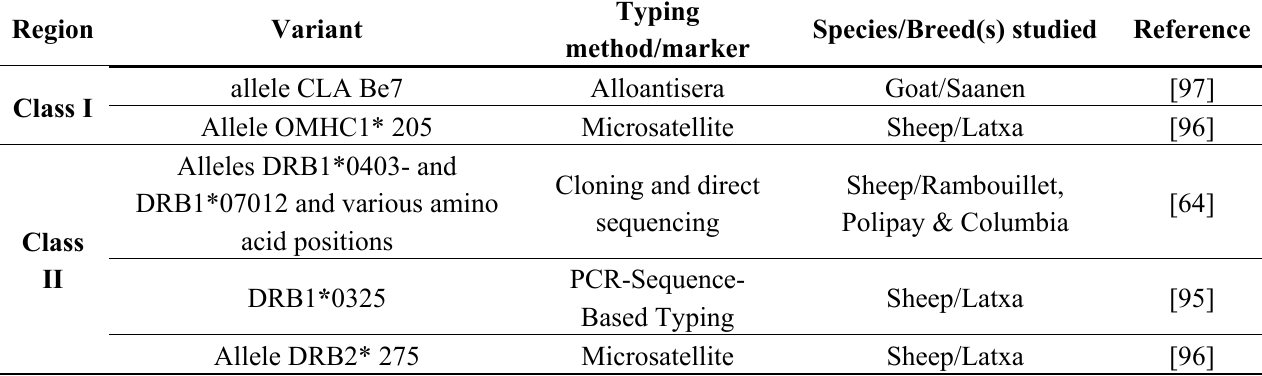
Table 2. Major histocompatability complex (MHC) genes/variants associated with VM or CAE